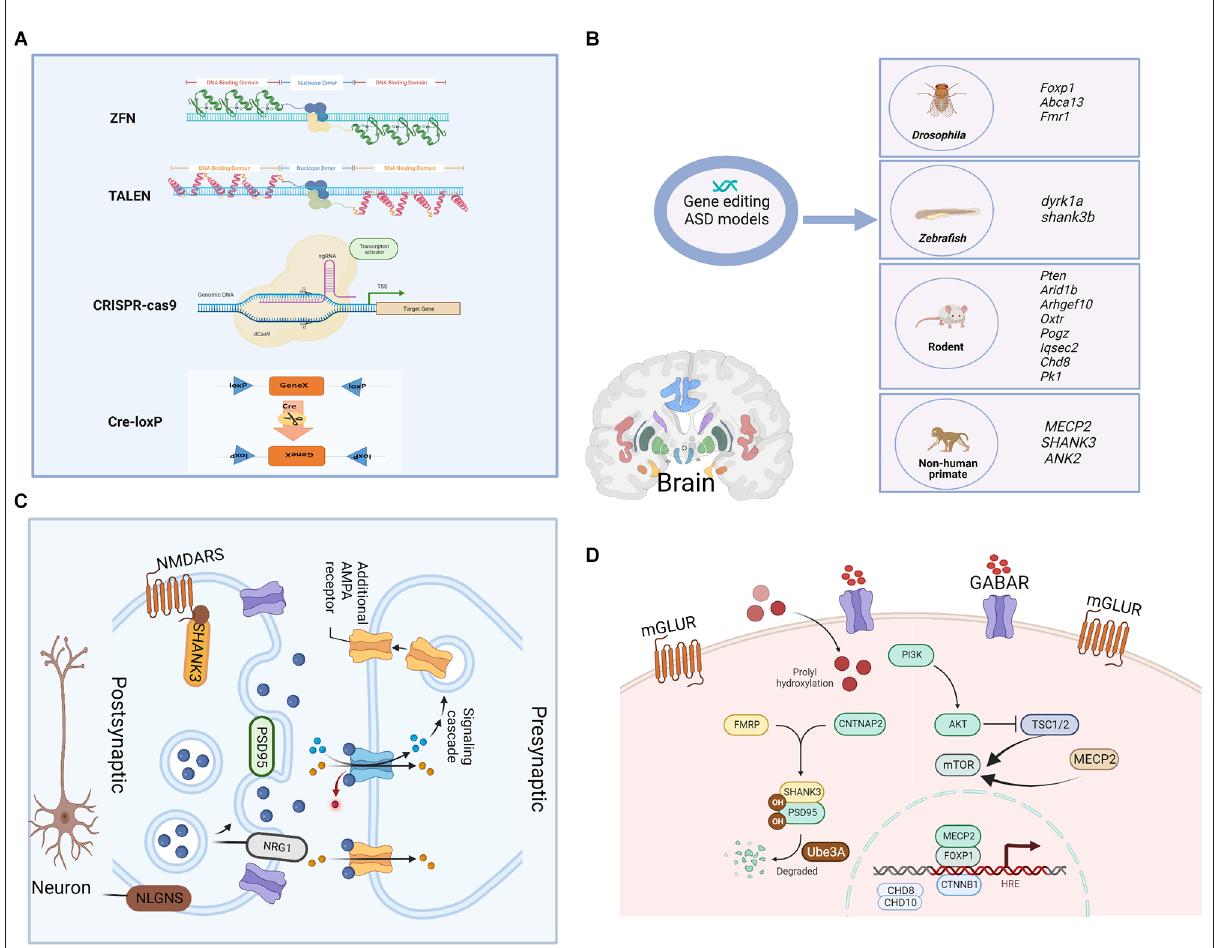
FIGURE1 Gene-editing technologies and single gene-edited animal models of ASD as well as the synaptic and cellular functions of modified genes. (A) The main genomic editing technologies available at the moment. (a) Zinc Finger Nucleases—ZFNs; (b) Transcription Activator-Like Effector Nucleases—TALENs; (c) CRISPR/Cas9; and (d) Cre-loxP recombinase system. (B) Single gene-edited animal models of ASD. Functions of the shown genes: Foxp1 . forkhead box protein 1, encodes a transcription factor important for the early development of many organ systems, including the brain. Abca13 : ATP-binding cassette protein A13, is predicted to have the typical structure of full-size ABC proteins, consisting of two transmembrane domains (TMDs). Fmr1 : fragile X mental retardation 1, is primarily associated with neuro/psychiatric risks. dyrk1a : dual specificity tyrosine phosphorylation regulated kinase 1A, is a murine homolog of the Drosophila minibrain gene and has been found to be involved in many biological processes during development and adulthood. shank3b : SH3 and multiple ankyrin repeat domains 3, are predicted to enable ionotropic glutamate receptor binding activity and synaptic receptor adaptor activity. Pten : phosphatase and tensin homolog, is an essential gene for proper control of cell movement and migration. Arid1b : ATT-rich interaction domain 1B, encodes a chromatin remodeling factor, and its haploinsufficiency can cause abnormal gene expression in the brain and induce ASD-like behaviors in mice. Arhgef10 : Rho guanine nucleotide exchange factor 10, is a known guanine nucleotide exchange factor (GEF) for RhoA with proposed roles in various diseases. Oxtr : oxytocin receptor, shows close association with prosocial behavior, and produced numerous pro-social effects through intranasal applications of oxytocin. Pogz : pogo transposable element derived with ZNF domain, encodes a multidomain nuclear protein involved in transcriptional regulation and its defective function has been recently associated with a syndromic neurodevelopmental disorder. Iqsec2 : isoleucine-glutamine motif and Sec7 domain-containing protein 2, is an X-linked gene that is associated with an autism spectrum disorder. Chd8 : chromodomain helicase DNA binding protein 8, functions in several processes that include transcriptional regulation, epigenetic remodeling, promotion of cell proliferation, and regulation of RNA synthesis. Pk1 : prokineticin 1, encodes a nuclear receptor that may be a negative regulator of the Wnt/beta- catenin signaling pathway. MECP2 : methyl-CpG binding protein 2, is an X chromosome-linked protein coding gene encoding the MECP2 protein, which is important for the function of nerve cells and plays a role in maintaining connections (synapses) between neurons. SHANK3 : SH3 and multiple ankyrin repeat domains 3, play a role in the functioning of synapses, and act as a scaffold that supports the connections between neurons, ensuring that the signals sent by one neuron are received by another. ANK2 : giant ankyrin 2, plays a role in endocytosis and intracellular protein transport, and is required for synapse stability. (C) Synaptic function of modified genes in the ASD model. AMPA, α -amino-3-hydroxy- 5-methyl-4-isoxazole propionic acid; PSD95, postsynaptic density 95; NRG1, neuregulin; NMDARS, N-methyl D-aspartate (NMDA) receptors; NLGNS, Neuroligins. (D) Cellular function of modified genes in the ASD model. mGLUR, metabotropic glutamate receptors; GABAR, gamma- aminobutyric acid receptor; PI3K, phosphoinositide 3-kinase; TSC1/2, tuberous sclerosis 1/2; mTOR, mammalian target of rapamycin;